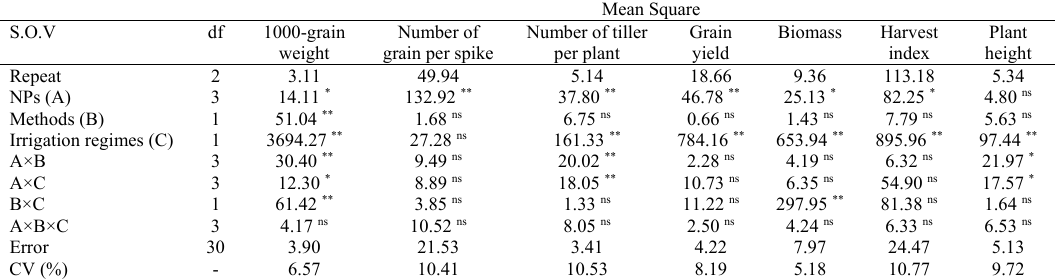
Table 2: Analysis of variance on some measured traits at barley affected by the treatments